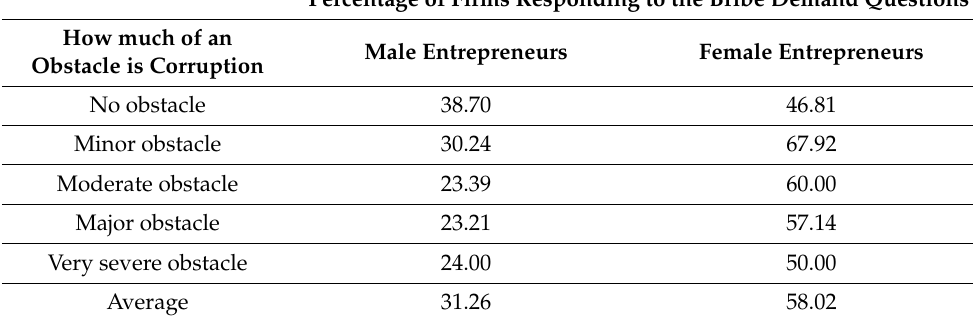
Table 4. Bribe demand responses as a percentage to how big an obstacle corruption is.